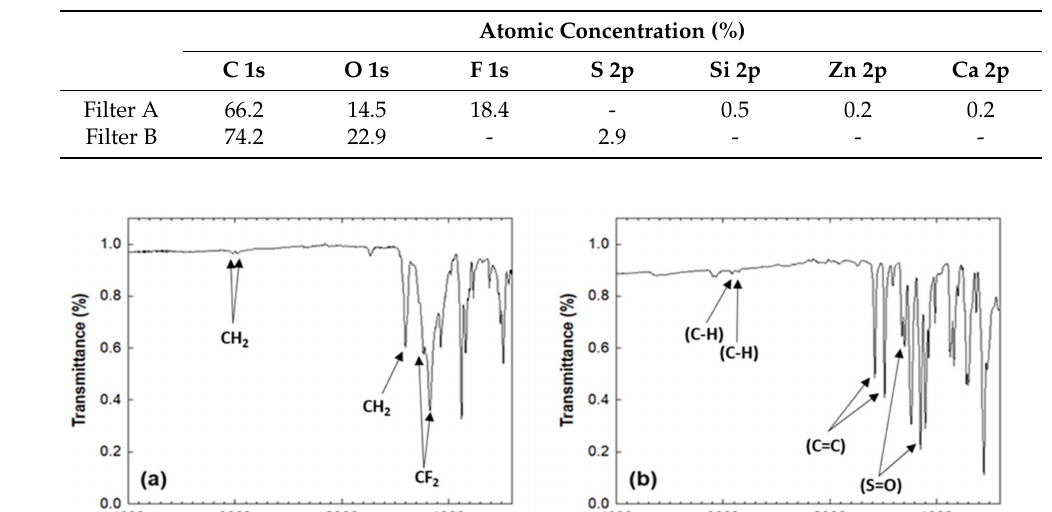
Table 1. XPS atomic compositions of filters A and B.